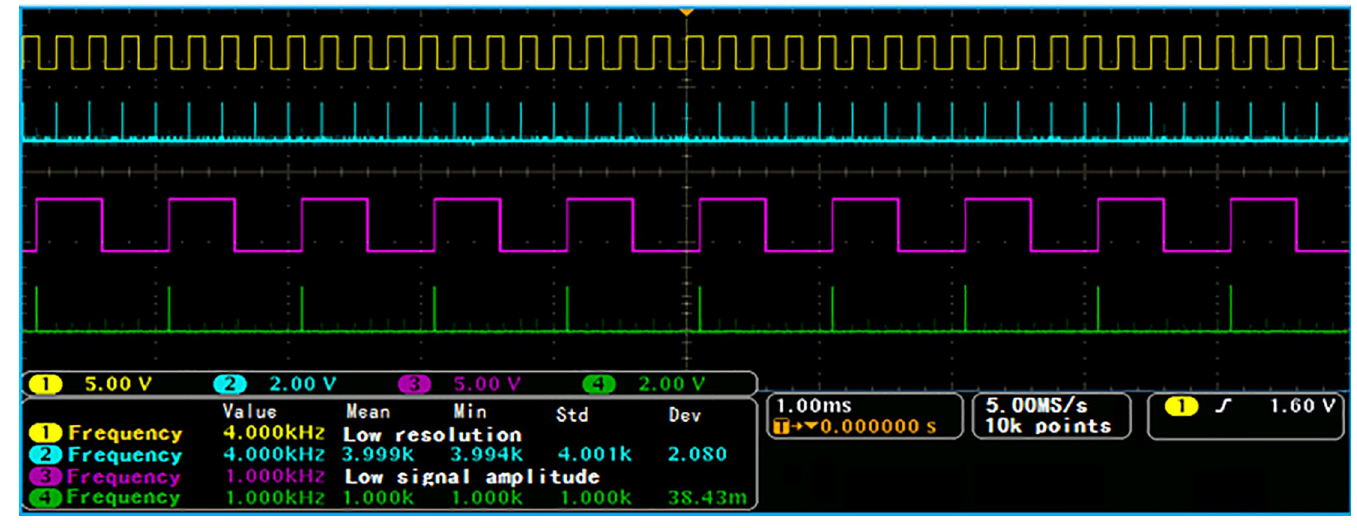
Fig 4. Pulse conversion test results.